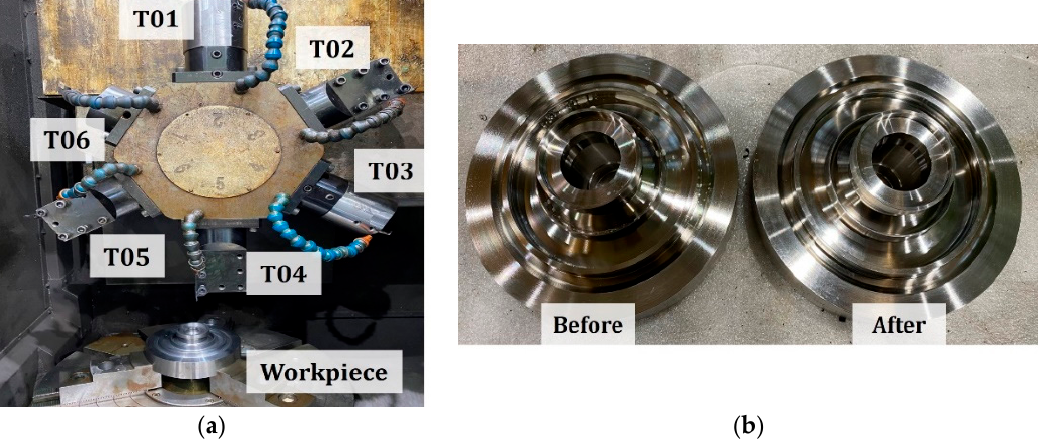
Figure 6. Experimental setup and the photograph of manufactured turbine disks. ( a ) Six cutting tool inserts and workpiece; ( b ) final products before and after feed optimization.